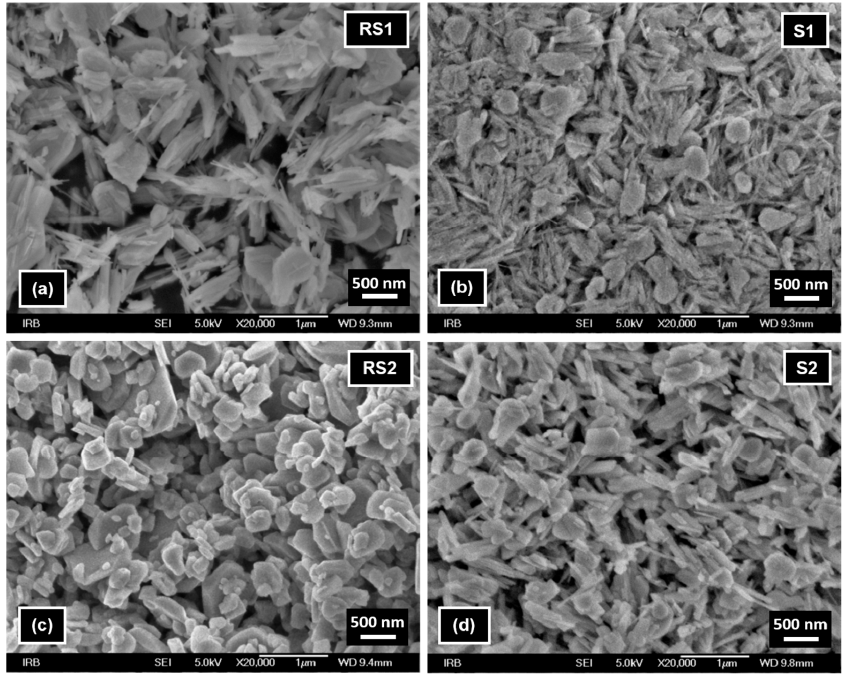
Figure 7. FE-SEM images of samples ( a ) RS1, ( b ) S1, ( c ) RS2, and ( d ) S2 recorded at magnification of 20,000×. FE-SEM images of reference sample RS3 (Figure 8a) and samples S3 and S7 (Figure 8b–d) show the presence of similar irregular hematite particles of about several tens of nm to 1 μ m in size. These images indicate an insignificant influence of the presence of CTAB during high-temperature (250 °C) synthesis on the size and shape of hematite particles.